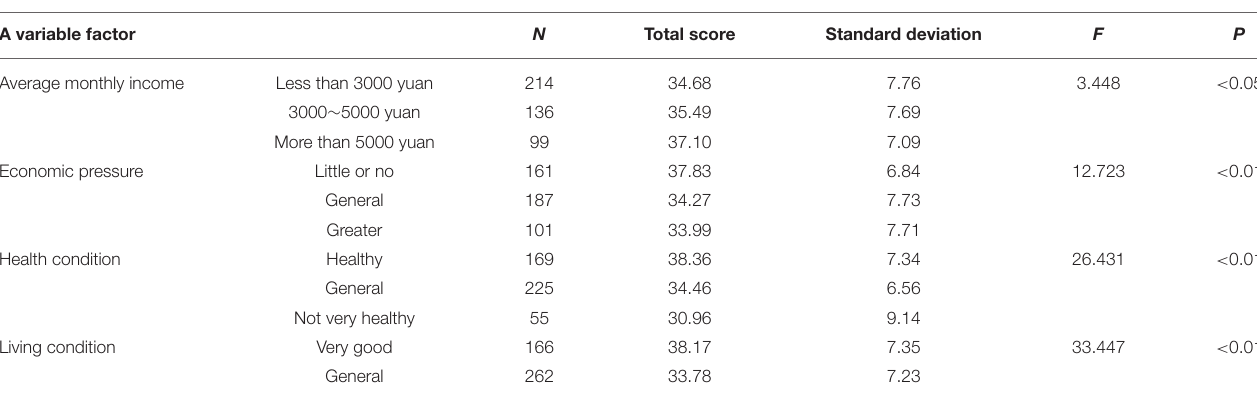
TABLE 3 | Analysis of differences in demographic variables.